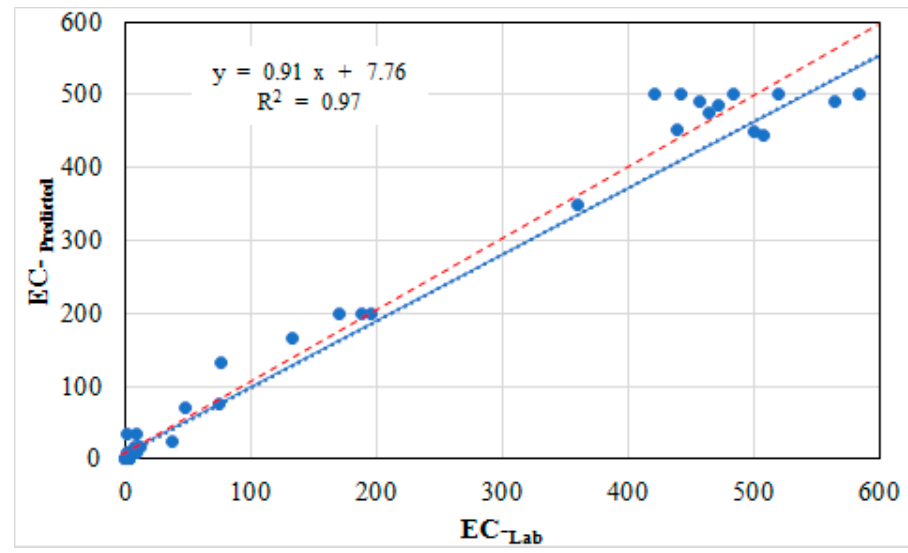
Figure 7. Relationship between EC -Lab and EC -Predicted values in dS.m − 1 ( p ˂ 0.05) . The blue line is the statistical trend, while the red is the first bisector (1:1 line).